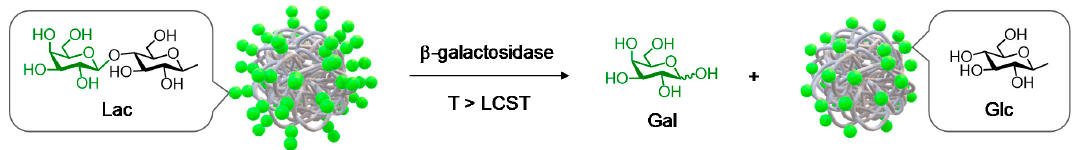
Figure 5. Schematic of the enzymatic treatment to confirm and quantify the saccharide moieties on the aggregates’ surface.